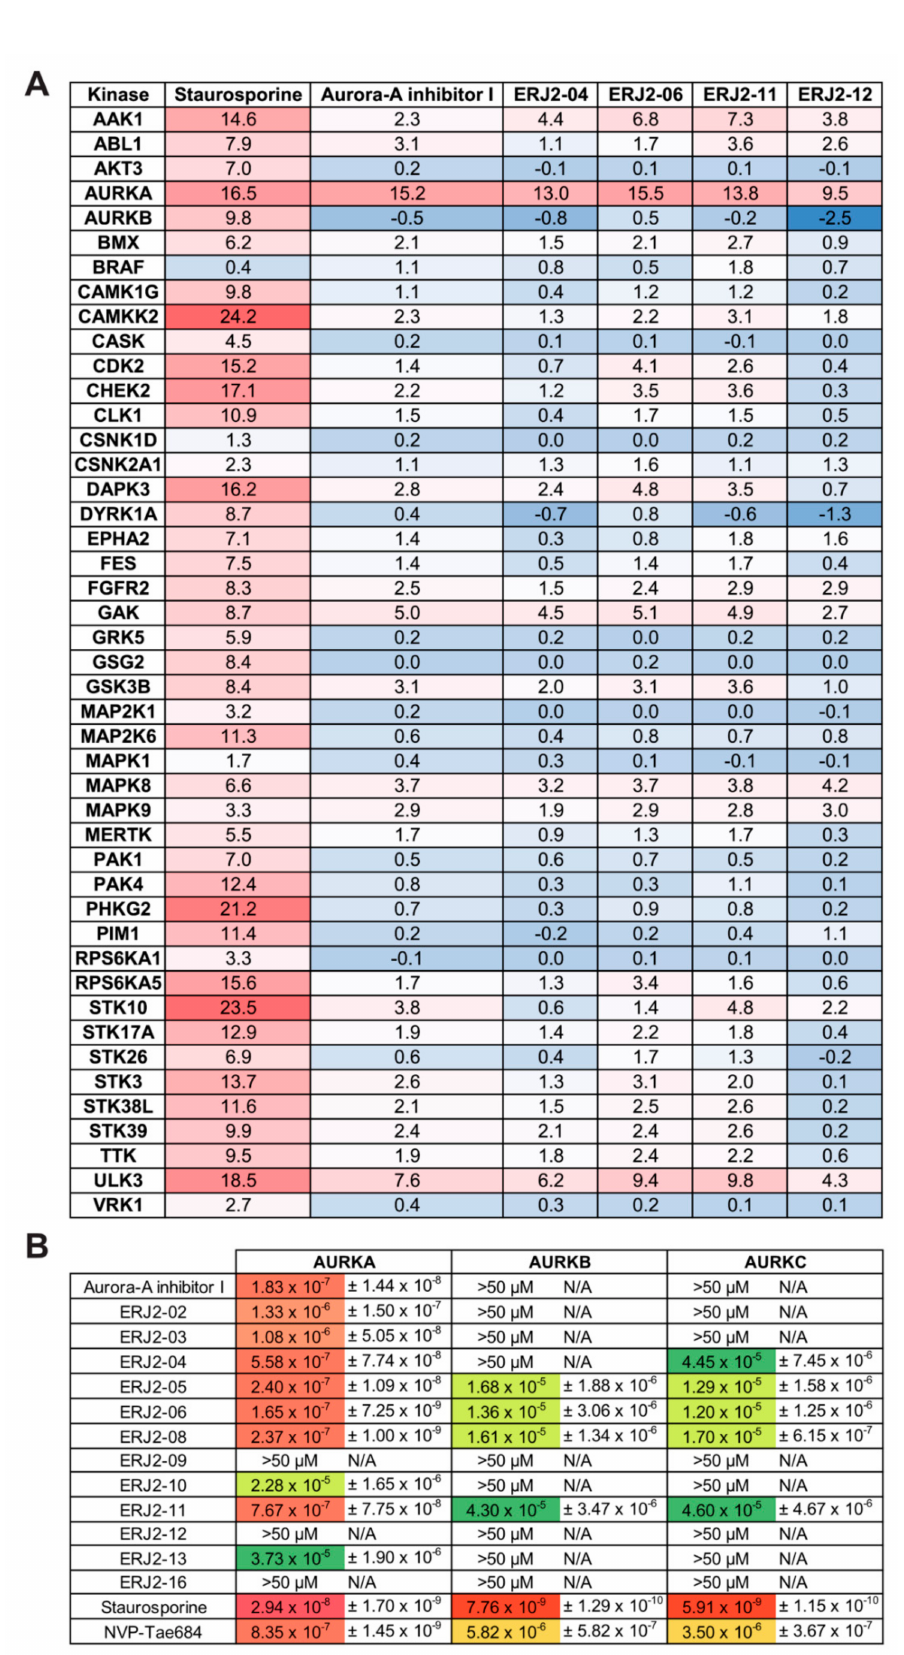
Figure 6. Aurora-A inhibitor I and its derivatives are mostly selective for AURKA. ( A ) Thermal shift assay to determine binding of Aurora-A inhibitor I and its derivatives to different kinases.